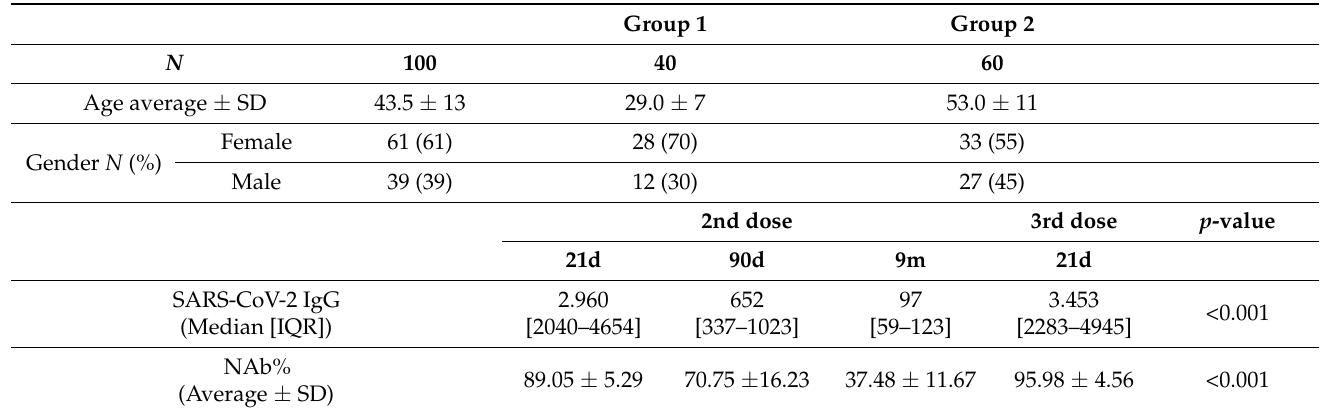
Table 1. Population Characteristics. Abbreviations: IQR = interquartile range; SD = Standard devia- tion; Nab = Neutralizing antibodies; N = Number of subjects; 21d = twenty-one days, 90d = ninety days, 9m = nine